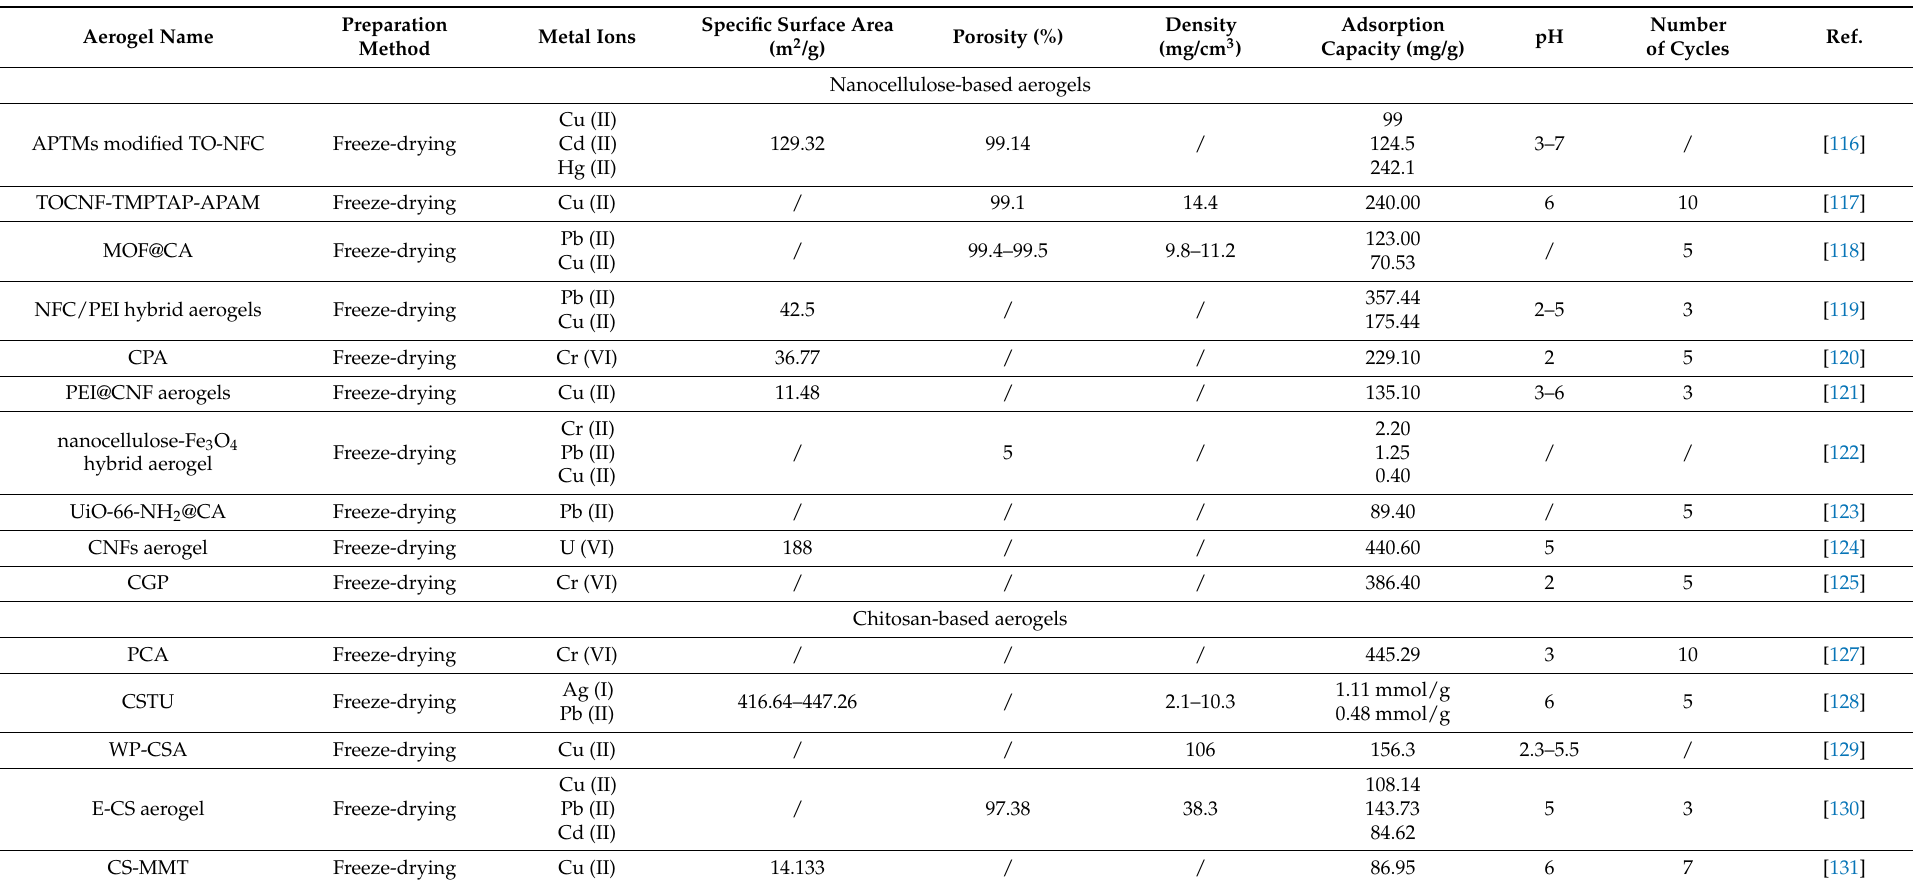
Table 5. Performance of nanocellulose-based aerogels in metal ion removal compared with chitosan-based aerogels. PCA: polyethyleneimine (PEI) functionalized chitosan (CS) aerogel; CSTU: thiourea-chitosan (CSTU) aerogel; WP-CSA: waste paper/chitosan aerogel; E-CS aerogel: enhanced chitosan aerogel; CS-MMT: chitosan-montmorillonite composite